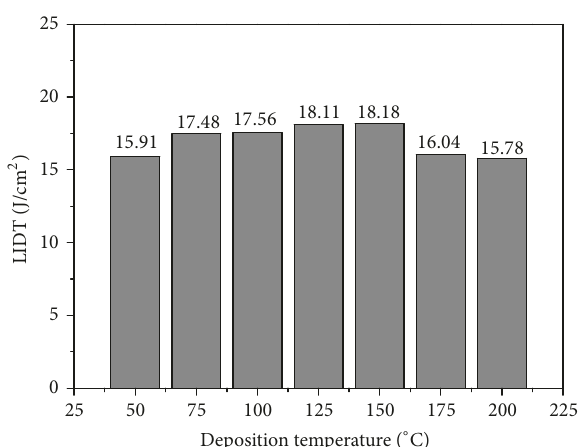
Figure 6: LIDT of LaTiO 3 film prepared at different deposition